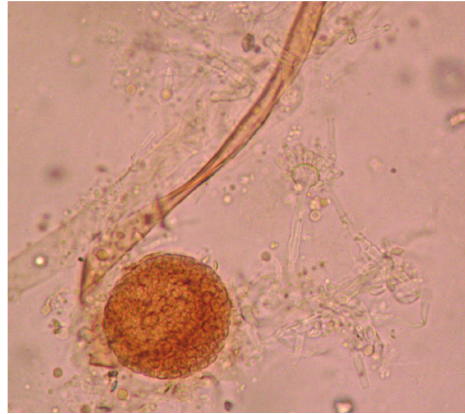
Figure 2: Thin, septate hyphae with vesicle and conidia along with aseptate hyphae and sporangium in KOH preparation from tissue